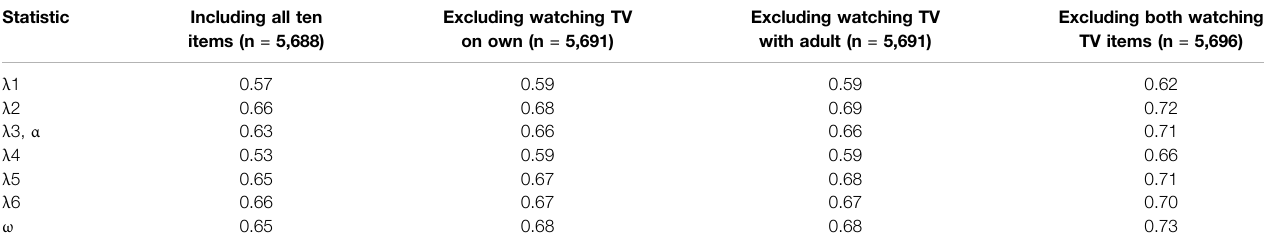
TABLE 4 | Internal consistency of the ten items measuring the Toddler Home Learning Environment and toddlers ’ television watching (Cronbach ’ s α , Guttmann ’ s λ s, and McDonald ’ s ω ). Statistic Including all ten items (n = 5,688)